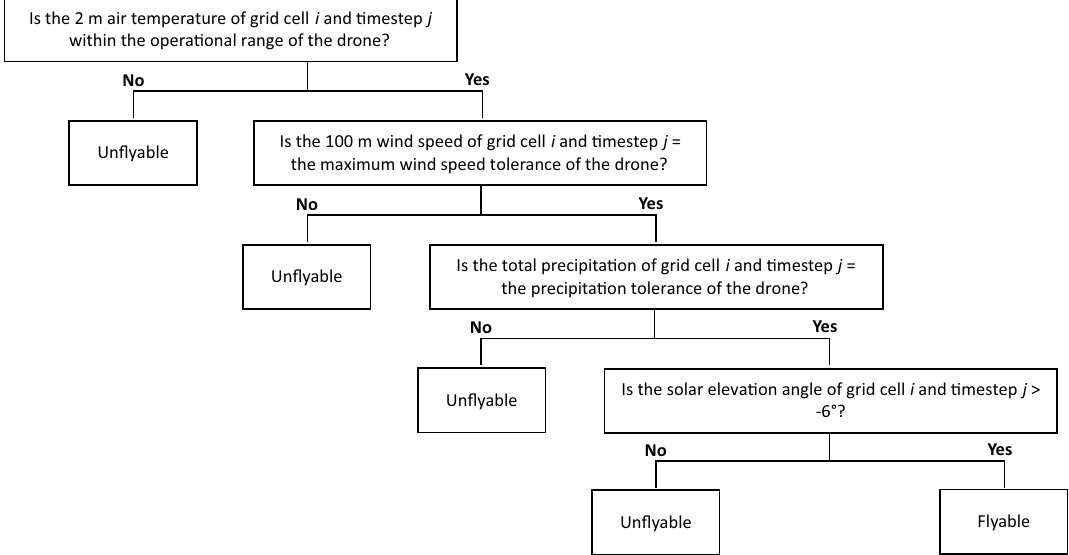
Figure 6. Binary decision diagram used to determine if the weather conditions corresponding to each grid cell and timestep combination were suitable for drone flight for the common and weather-resistant drone classes. If all meteorological requirements were met, the grid cell and timestep combination was counted as one flyable timestep. The last decision rule based on daylight was included in the additional